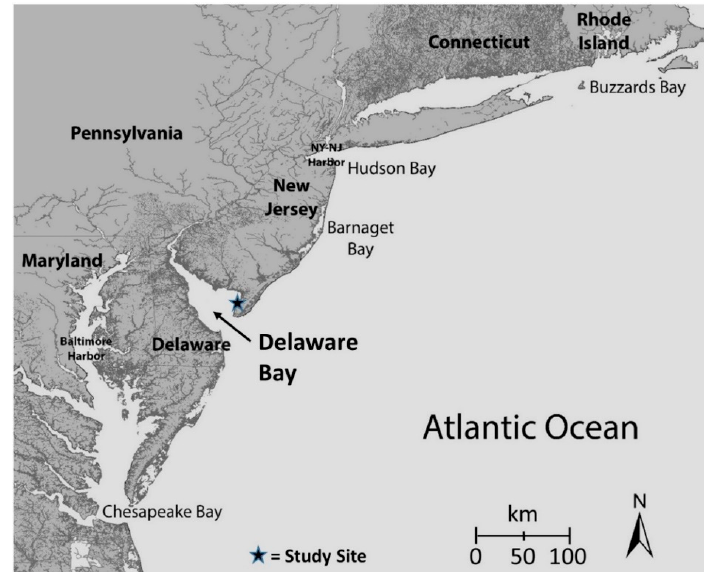
Figure 1. Map showing the location of Delaware Bay, between the states of New Jersey and Delaware. Arrow shows the approximate location of sampling.